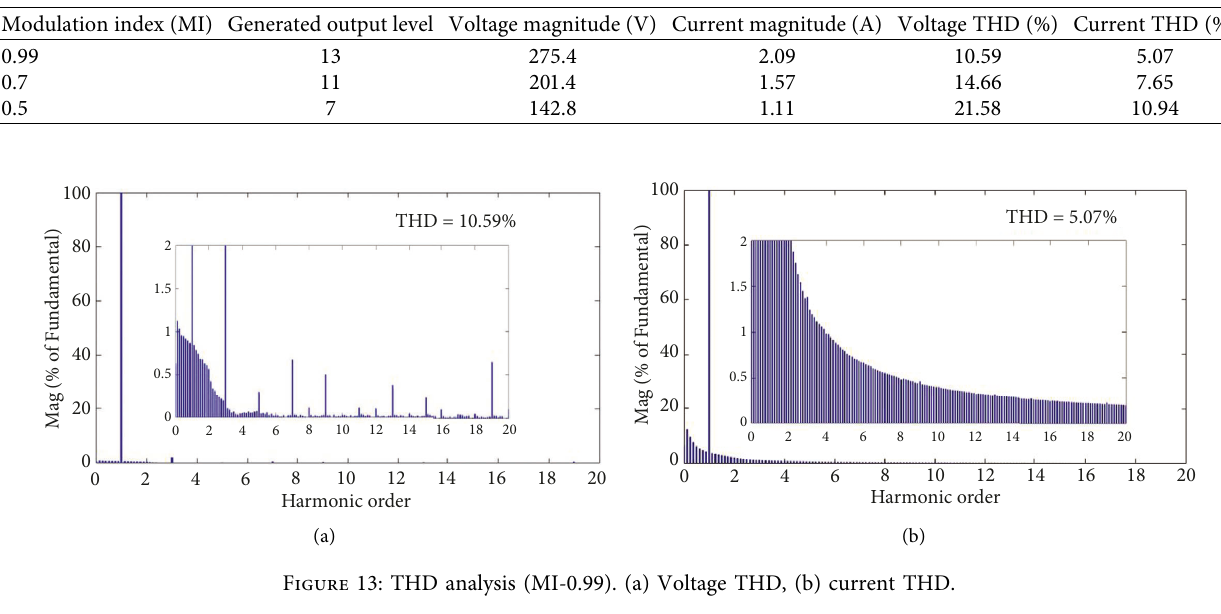
Table 3: Result summary.